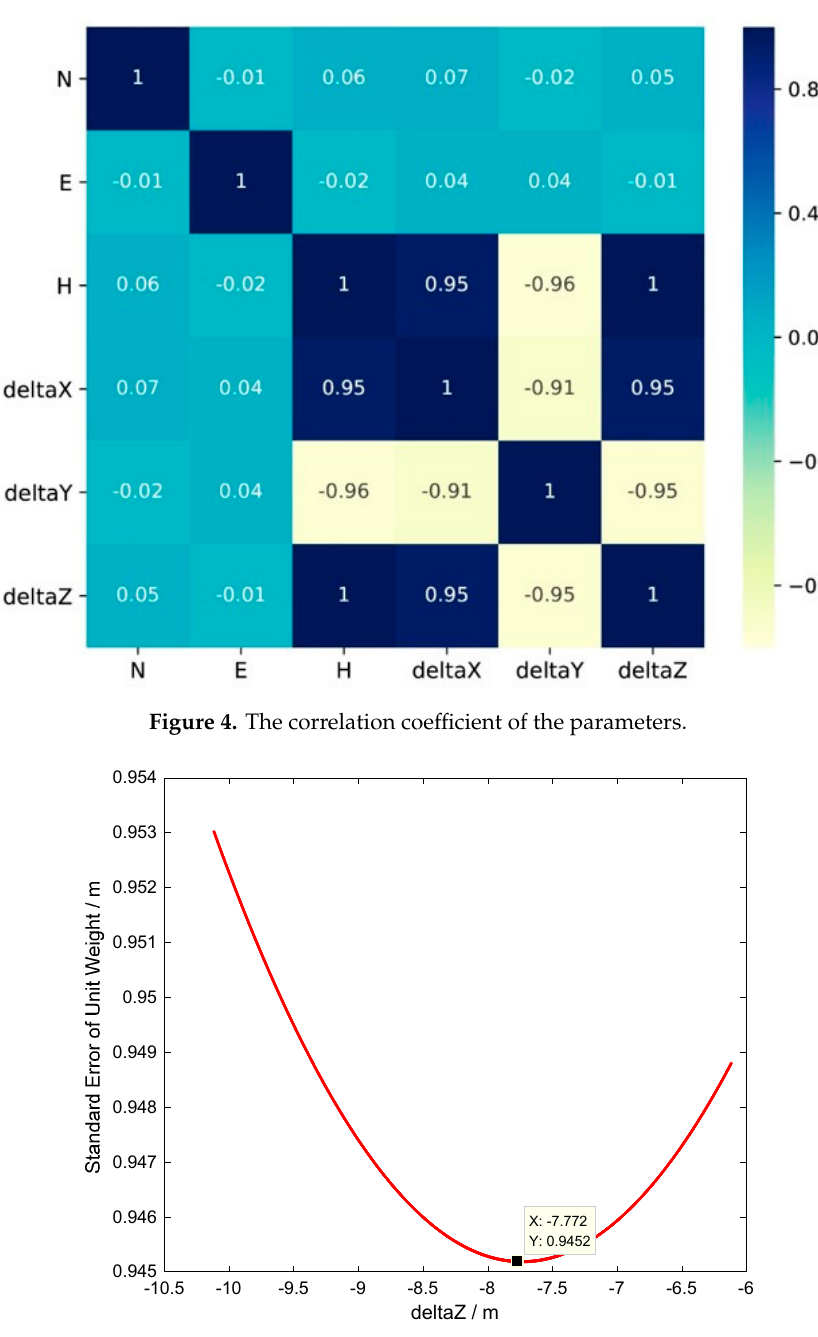
Figure 5. The relation between the vertical lever arm and the mean square error of unit weight. Table 2. Results of Two Estimation Model (Unit: m).